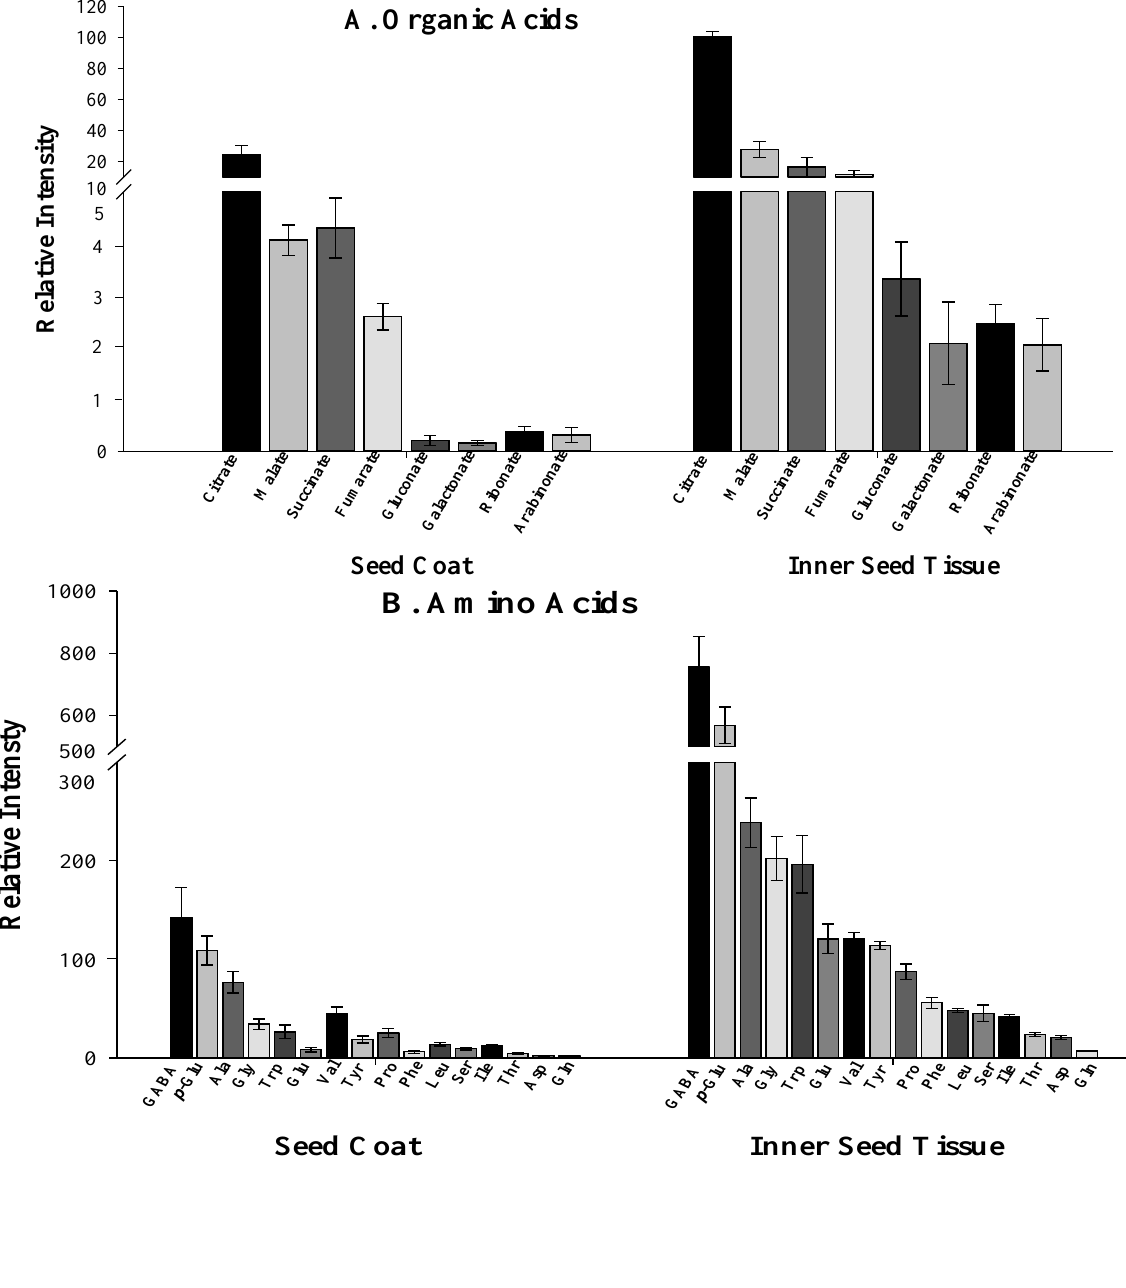
Figure 7. Distribution of central metabolites in the seed coat and inner seed tissues of N. sativa. Analyses were performed by GC-MS after derivatization with methoxyamine hydrochloride (20 mg/mL in pyridine). Relative content is given as the metabolite response (metabolite peak intensity/internal standard peak intensity/FW). The error bars in graphs refer to the mean values ± SE of four replicates. All the metabolites shown displayed significantly differences between seed coats and inner seed tissues ( t test, p <